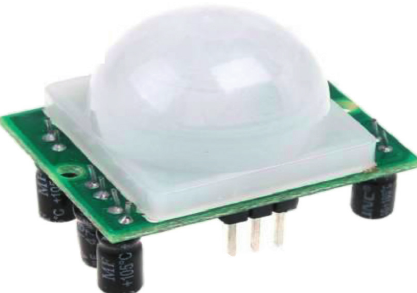
Figure 4: Passive infrared sensor.